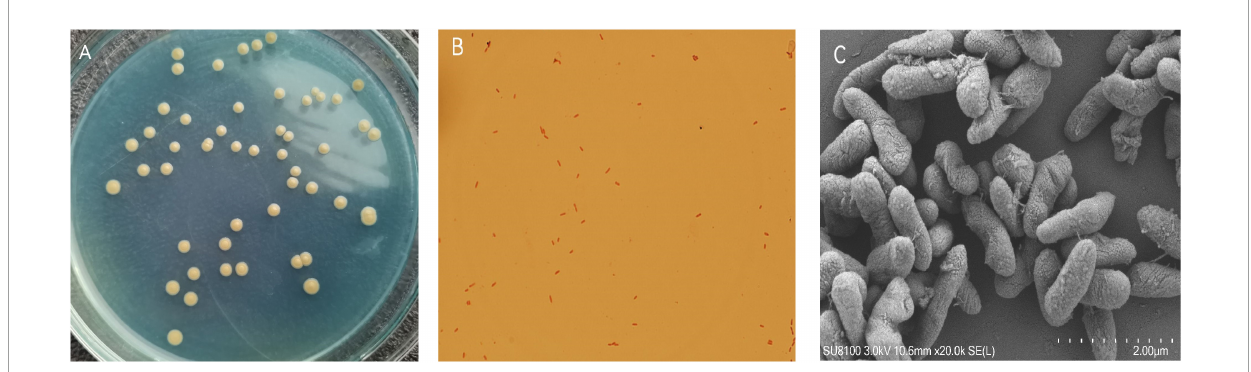
FIGURE1 The colony morphologies of the strain EN-J1. (A) Colonies on BTB plate; (B) gram staining result under optical microscope; (C) cells shape by the scanning electron